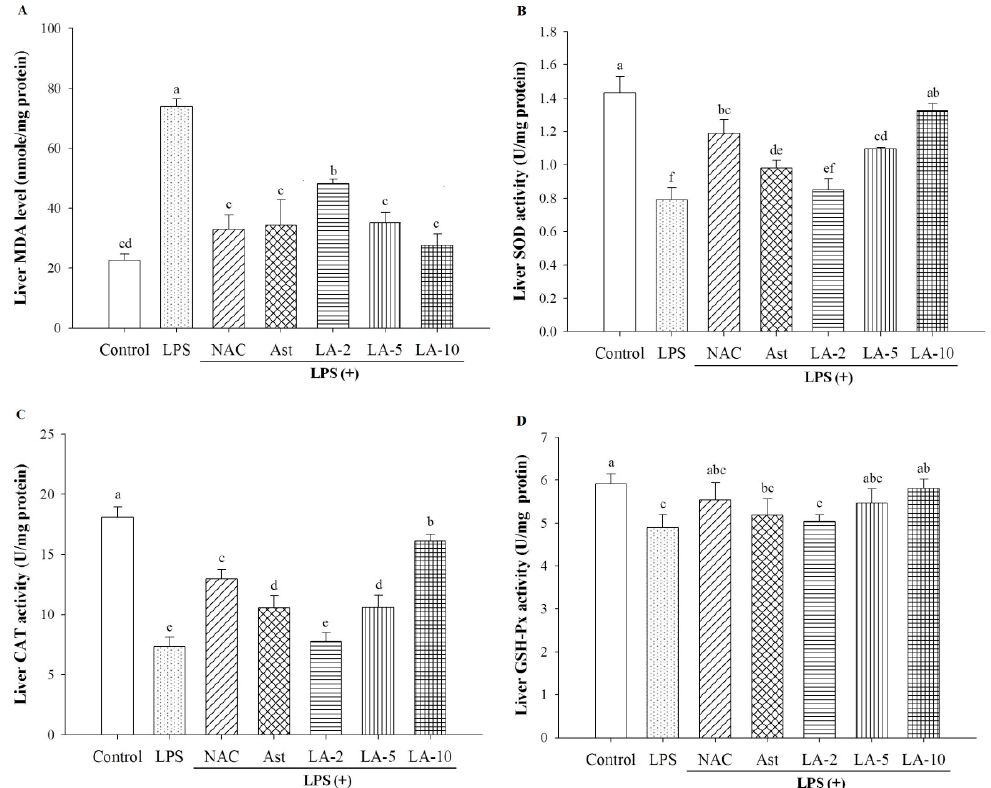
Figure 5. ( A ) Malondialdehyde (MDA), ( B ) superoxide dismutase (SOD), ( C ) catalase (CAT) and ( D ) glutathione peroxidase (GSH-Px) levels in liver. Each bar represents the mean ± SEM of three to four rats per group. Different letters indicate significant differences between groups. Statistical